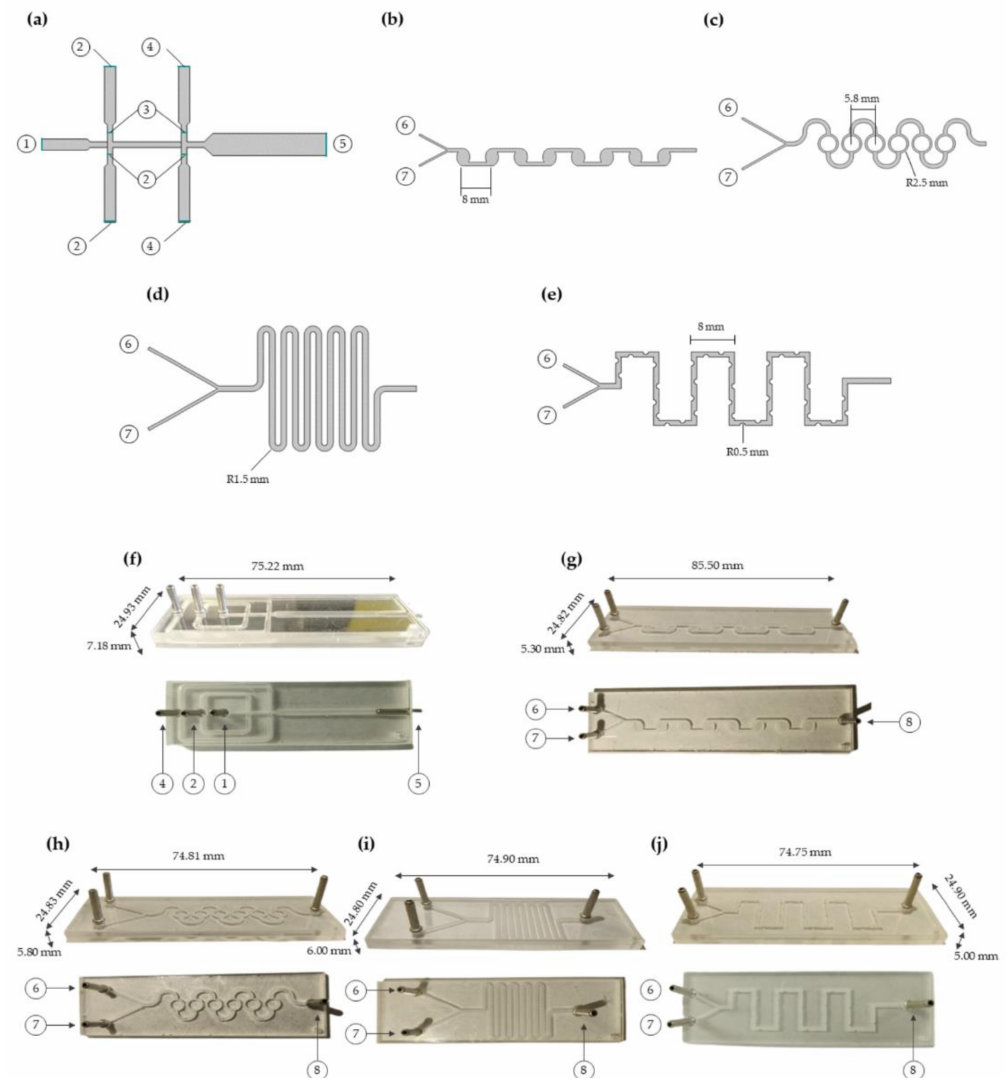
Figure 2. Design of 2D geometries for simulation of the microfluidic devices and further manufactured devices. ( a ) Double emulsion droplet generation microfluidic system. Inner continuous phase inlet of 1 mm width 1 (cid:13) , dispersed phase inlet of 1 mm width 2 (cid:13) , inlet channels constriction of 0.5 mm width and narrowing section junction 3 (cid:13) . Outer continuous phase inlet of 1 mm width 4 (cid:13) , and flow outlet channel of 2 mm width 5 (cid:13) . ( b ) Chambers geometry micromixer. ( c ) SARS geometry micromixer. ( d ) Serpentine geometry micromixer. ( e ) Serpentine with circular features geometry micromixer and continuous (GUVs) 6 (cid:13) and dispersed (yeasts) 7 (cid:13) phase inlet for all micromixers, respectively. ( f ) WOW microfluidic system for the generation of double emulsions with their respective dimmensions, 1 (cid:13) outer aqueous (OA) phase inlet, 2 (cid:13) lipid-carrying organic (LO) phase inlet, 3 (cid:13) inner aqueous (IA) phase inlet, and 4 (cid:13) flow outlet. ( g ) Chambers, ( h ) SARS, ( i ) Serpentine, and ( j ) Serpentine with circular features micromixers with 5 (cid:13) GUVs inlet, 6 (cid:13) yeast homolgues (BUF-II-CSMPs-RhodB) inlet, 8 (cid:13) flow outlets and their respective